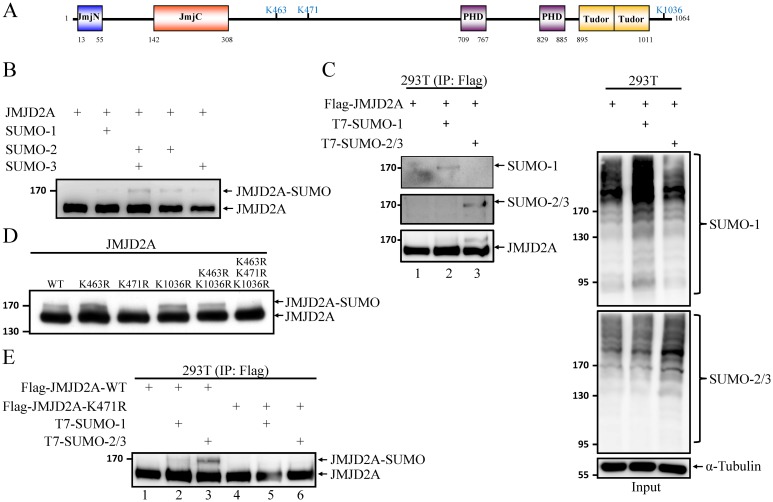
JMJD2A is SUMOylated at K471.(A) Schematic representation of the domain structure of JMJD2A and the three putative SUMOylation sites. (B) in vitro SUMOylation assay using recombinant Flag-JMJD2A and SUMO isoforms as substrates. (C) in vivo SUMOylation assay was performed by transfecting 293T cells with plasmids expressing Flag-JMJD2A (0.4 μg) and T7-SUMO-1 or T7-SUMO-2 and -3 (1.2 μg). JMJD2A was immunoprecipitated (IP’d) with anti-Flag-M2 beads and analyzed by immunoblotting using anti-SUMO-1, anti-SUMO-2/3 and anti-JMJD2A antibodies (left panel). TCLs were immunoblotted with anti-SUMO-1, anti-SUMO-2/3 antibodies and anti-α-Tubulin (right panel). (D) Purified wild-type (WT) and different combinations of SUMOylation site mutants of Flag-JMJD2A were used for in vitro SUMOylation assay as described in (B). 4%-20% gradient SDS-PAGE was used to resolve JMJD2A and SUMOylated JMJD2A. (E) Flag-JMJD2A-WT or -K471R was expressed in 293T cells as described in (C) and IP’d using M2 beads. SUMOylated JMJD2A was analyzed with anti-JMJD2A antibody.